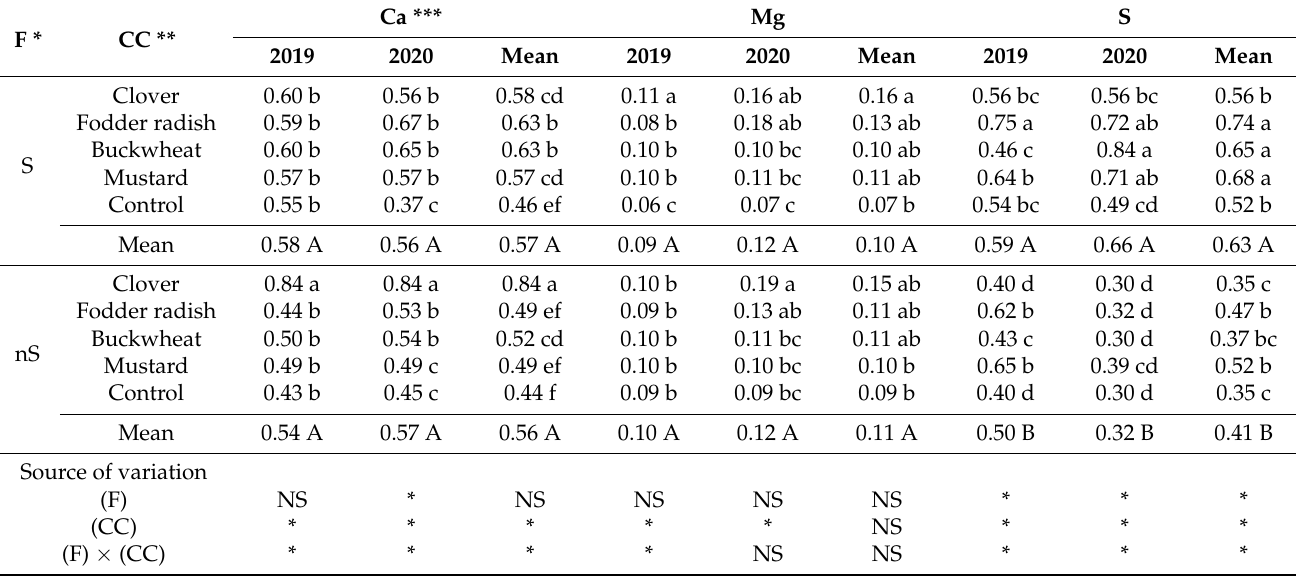
Table 3. Macronutrient analysis of winter garlic bulbs cultivated under sulfur and catch crops in